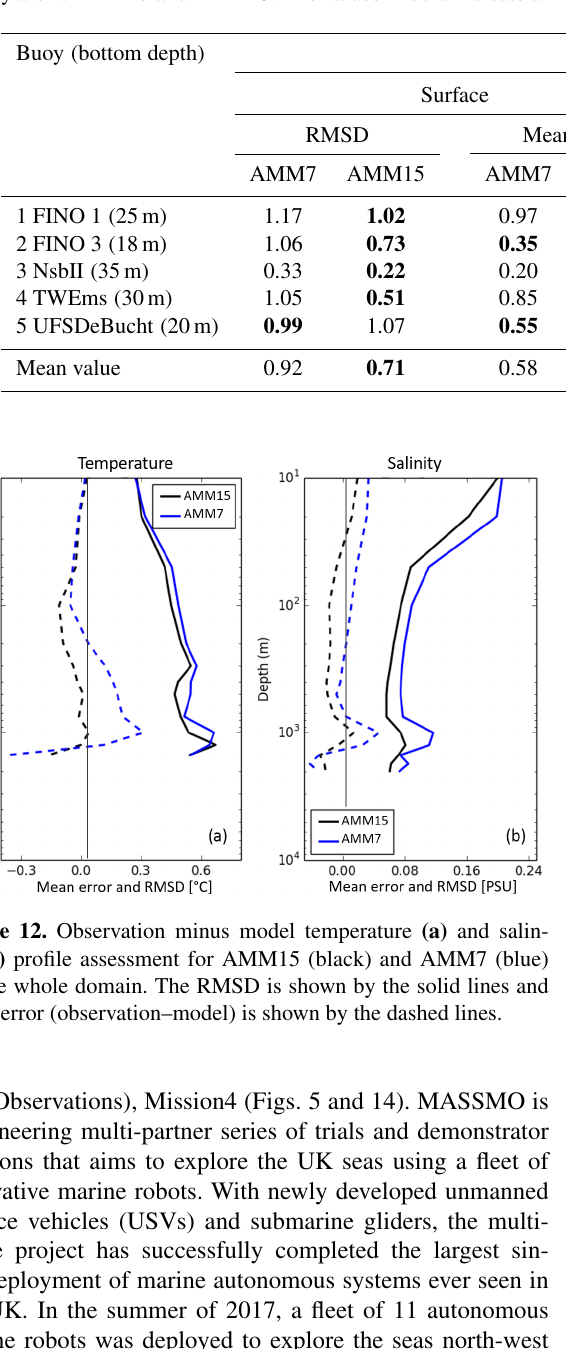
12:00 UTC on 23 May, when the glider was in the position marked by the red